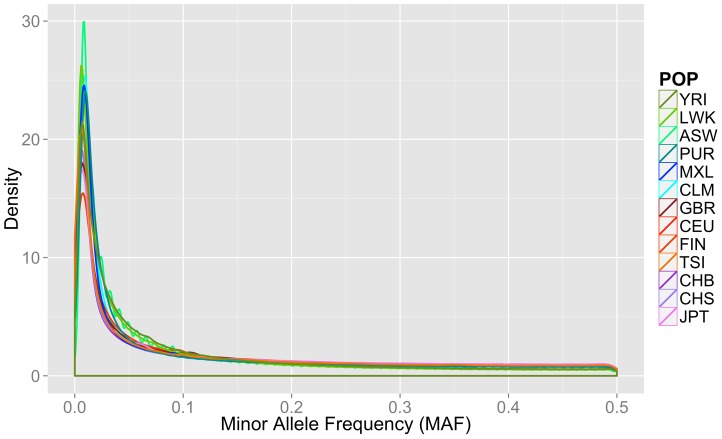
Minor allele frequency distribution on autosomal chromosomes for 13 1000 Genomes Project Phase I populations.Groups are color coordinated by continental ancestry: greens = African descent (YRI, LWK, ASW); blues = Mexican/Spanish descent (PUR, CLM, MXL); orange/reds = European descent (GBR, FIN, CEU, TSI); and pink/purple colors = Asian descent (JPT, CHB, CHS). The populations of African descent have the highest proportion of low frequency variation.